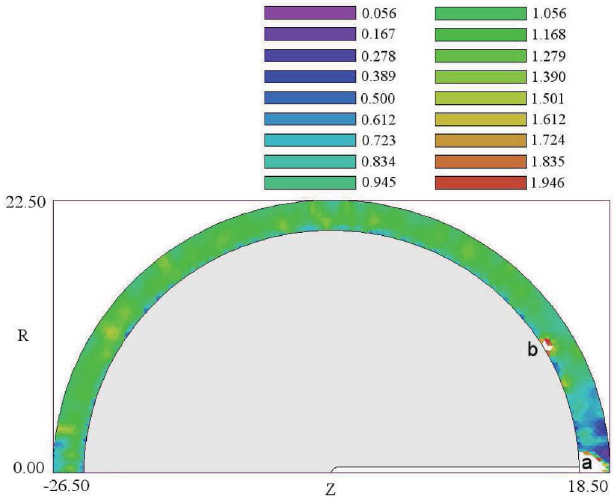
11. (Color) Smoothed photon dose rate ( Gy = s ) in the test volume, CRAD diode benchmark simulation. Multiply values by 10 9 .